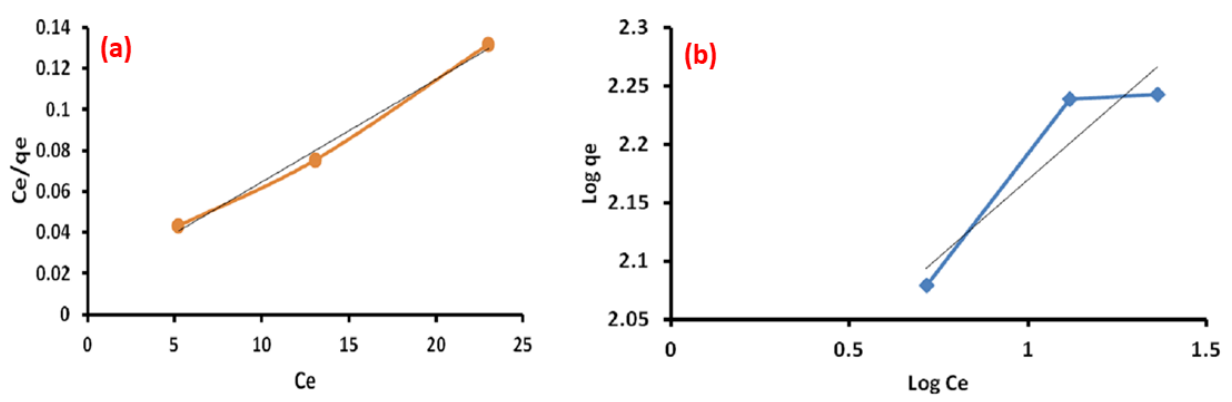
Figure 8. Plot of ( a ) Langmuir adsorption isotherm and ( b ) Freundlich adsorption isotherm. Table 2. Comparison of Langmuir and Freundlich isotherm constants. Langmuir Isotherm